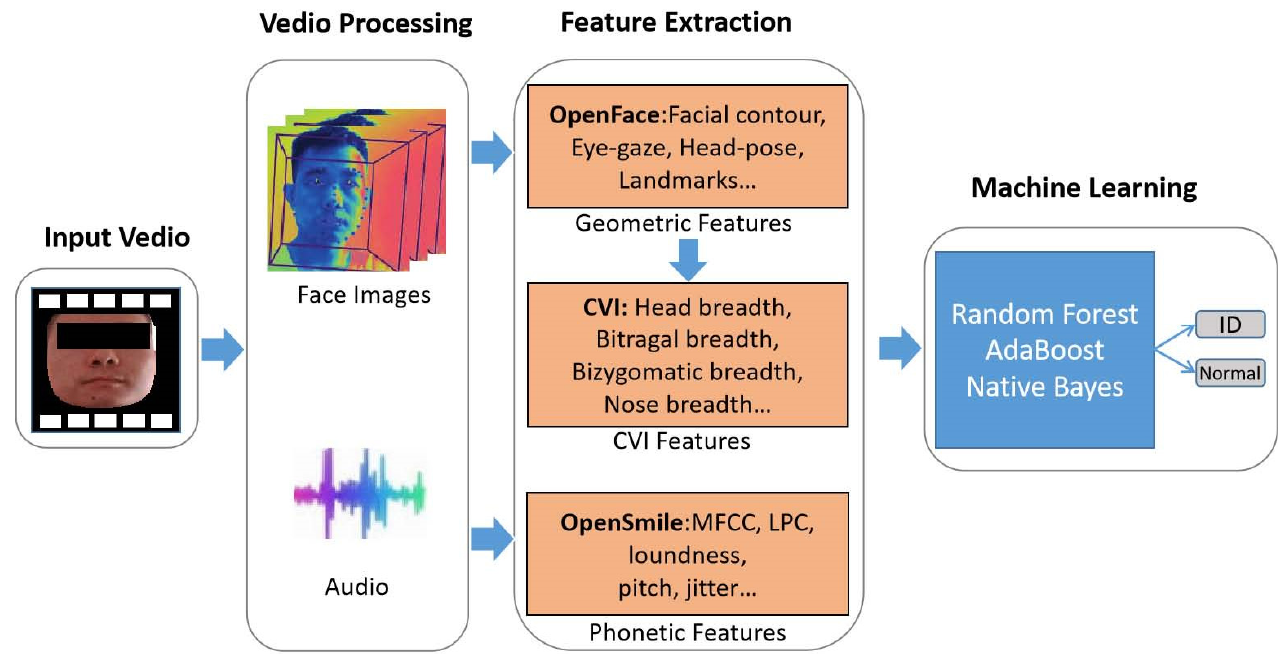
Figure 1. Architecture for screening ID.